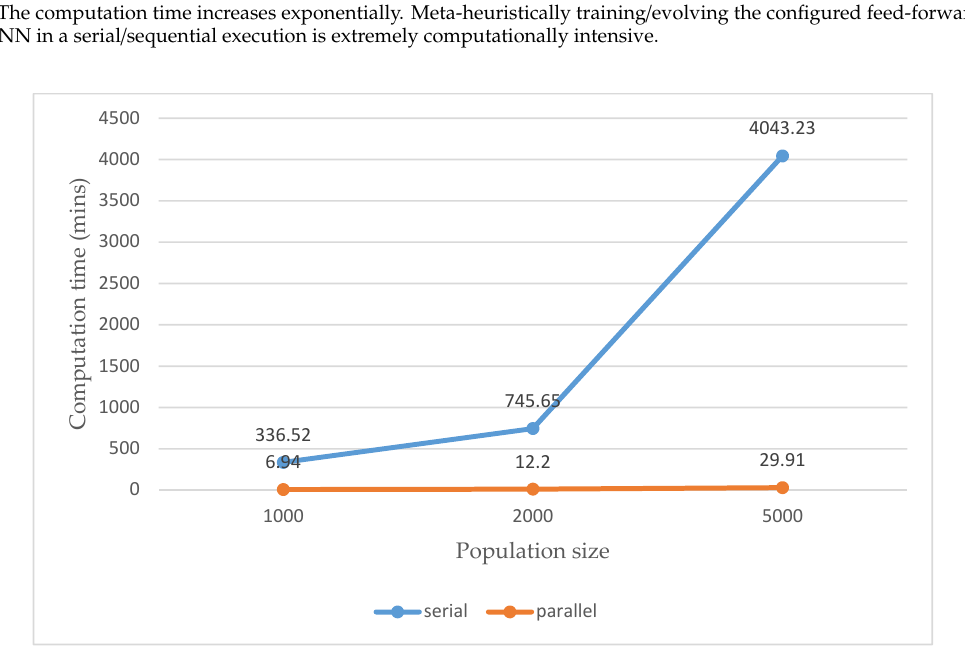
Figure 13. Computation time by the standard GA vs. the parallel GA in this experiment. The parallel GA against the standard GA has, in computation time, an acceleration of up to 135× (=4043.23/29.91) achieved.